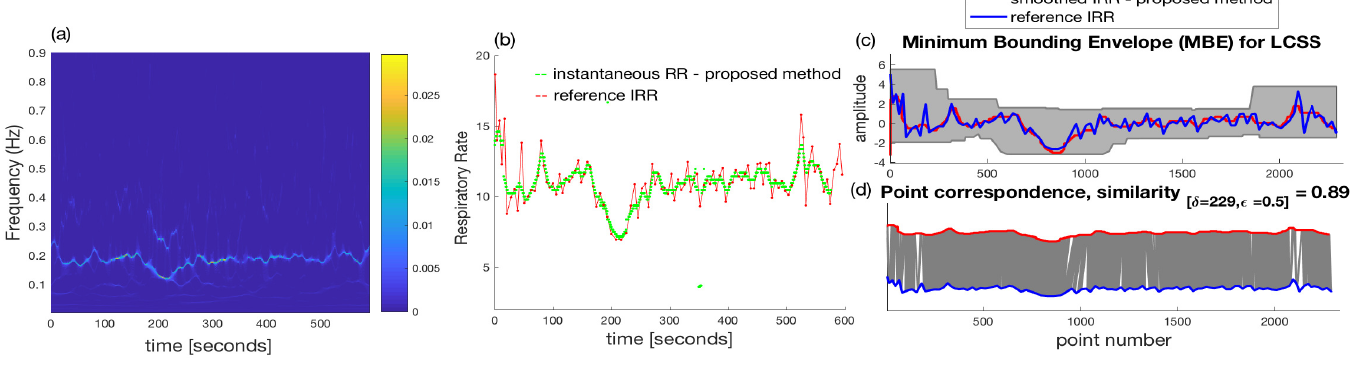
Figure 9. ( a ) The wavelet synchrnosqueezed transform of the derived and resampled FM for subject #3; ( b ) Estimated instantaneous respiratory rate using the proposed technique. The reference is shown in red color; ( c , d ) Similarity of estimated instantaneous respiratory rate and the reference using the longest common subsequence algorithm. A high similarity of 0.89 (maximum similarity is 1) has been obtained for subject #3. The reference RR has been shown in blue color in ( c , d